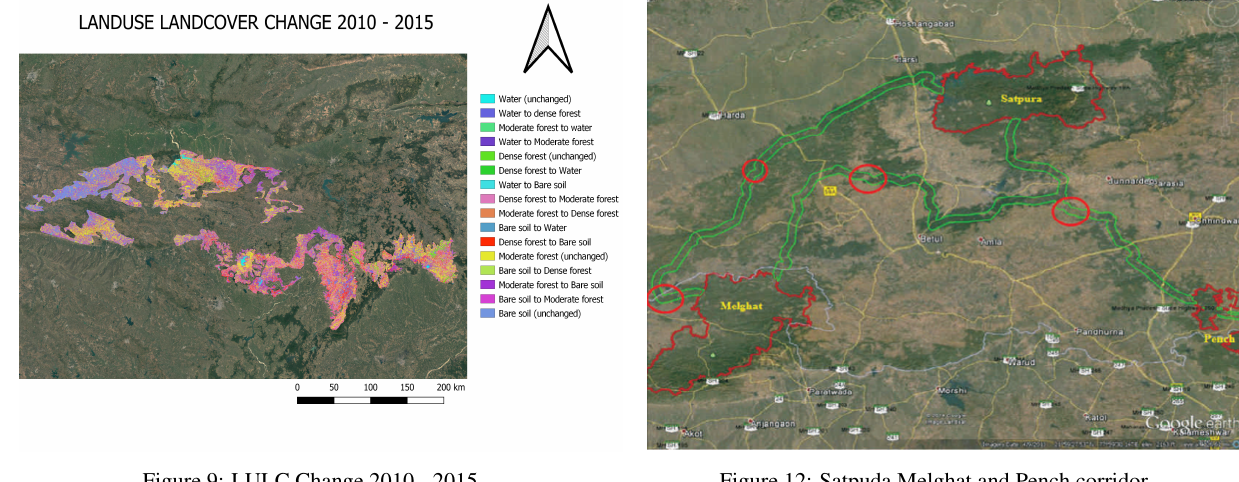
Figure 12: Satpuda Melghat and Pench corridor